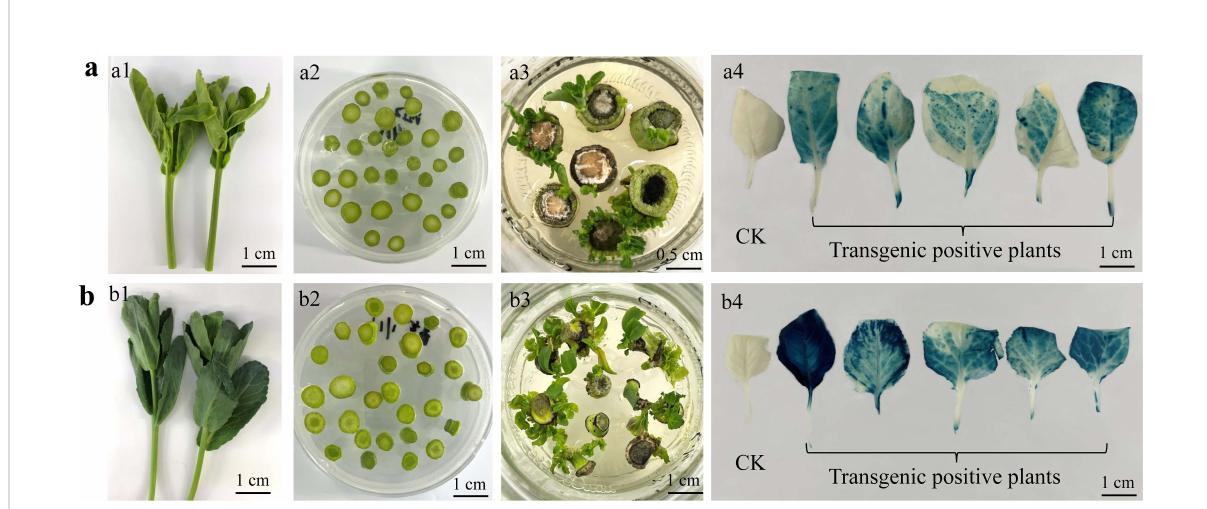
FIGURE 7 Transgenic plants regenerated from tender stems of lateral branches of Chinese kale (A) and cabbage (B) . The tender stems of lateral branches (A1, B1), which were cut into segments with a diameter of 0.3-0.8 cm (A2, B2). Resistant buds were regenerated from the tender stem explants (A3, B3) and the histochemical GUS staining of the leaves from transgenic positive plants (A4,